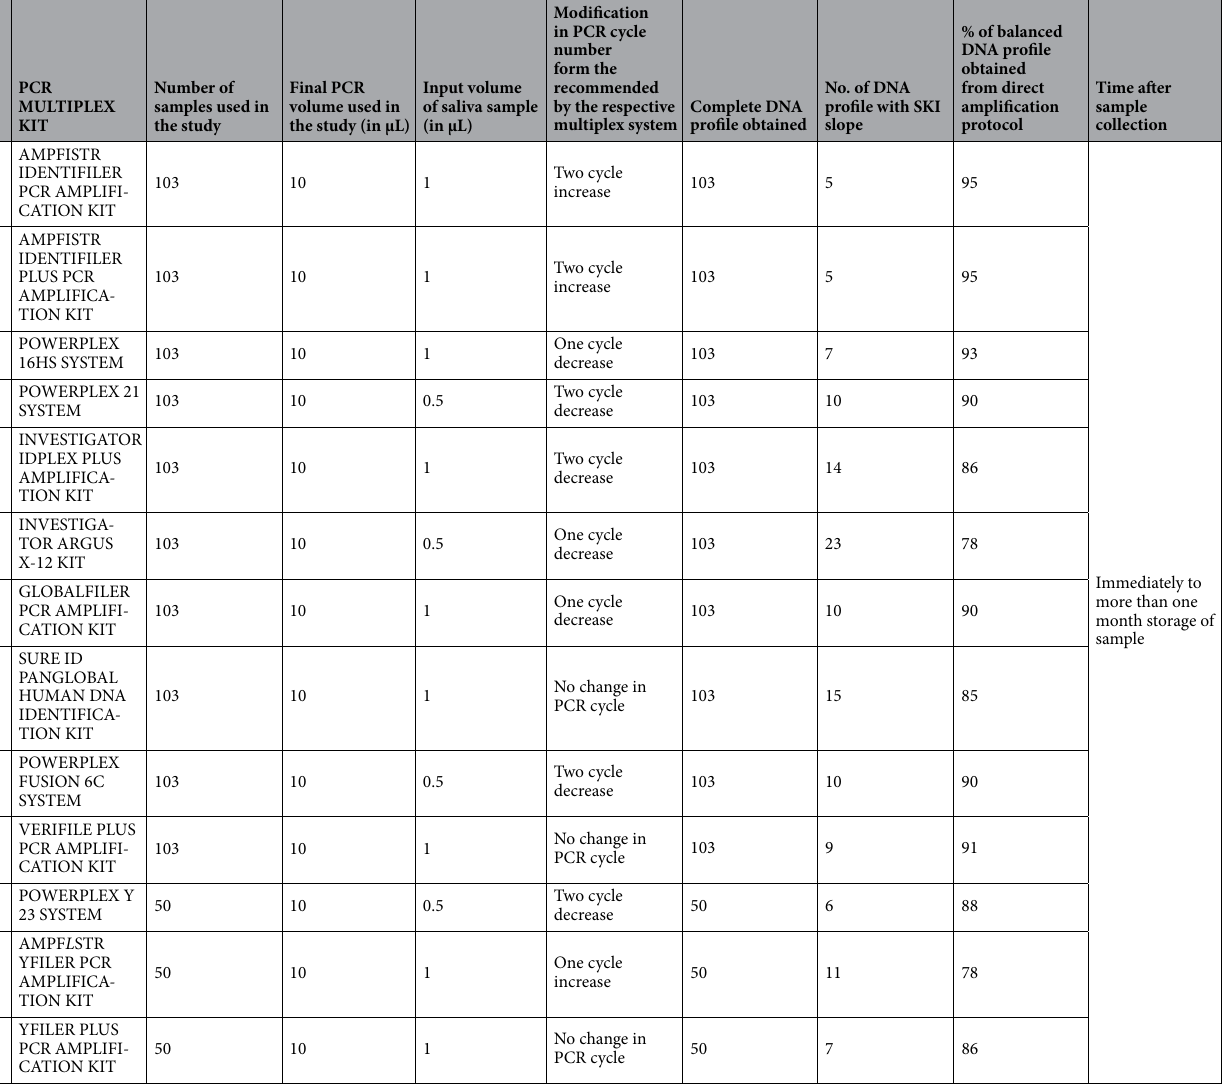
Table 3. Validated parameters of novel direct amplification